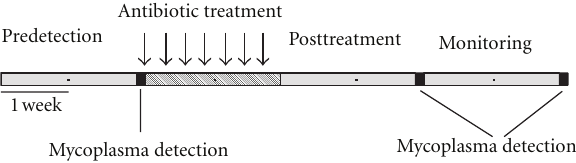
Figure 1: Treatment protocol for Plasmocin. The reagent is added to the medium at a final concentration of 25 µ g/mL on the days indicated by